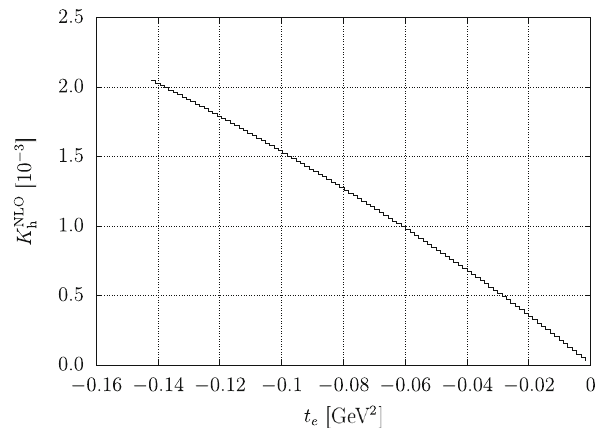
Fig. 10 The relative importance of the HVP at NLO in μ - e scattering as a function of t